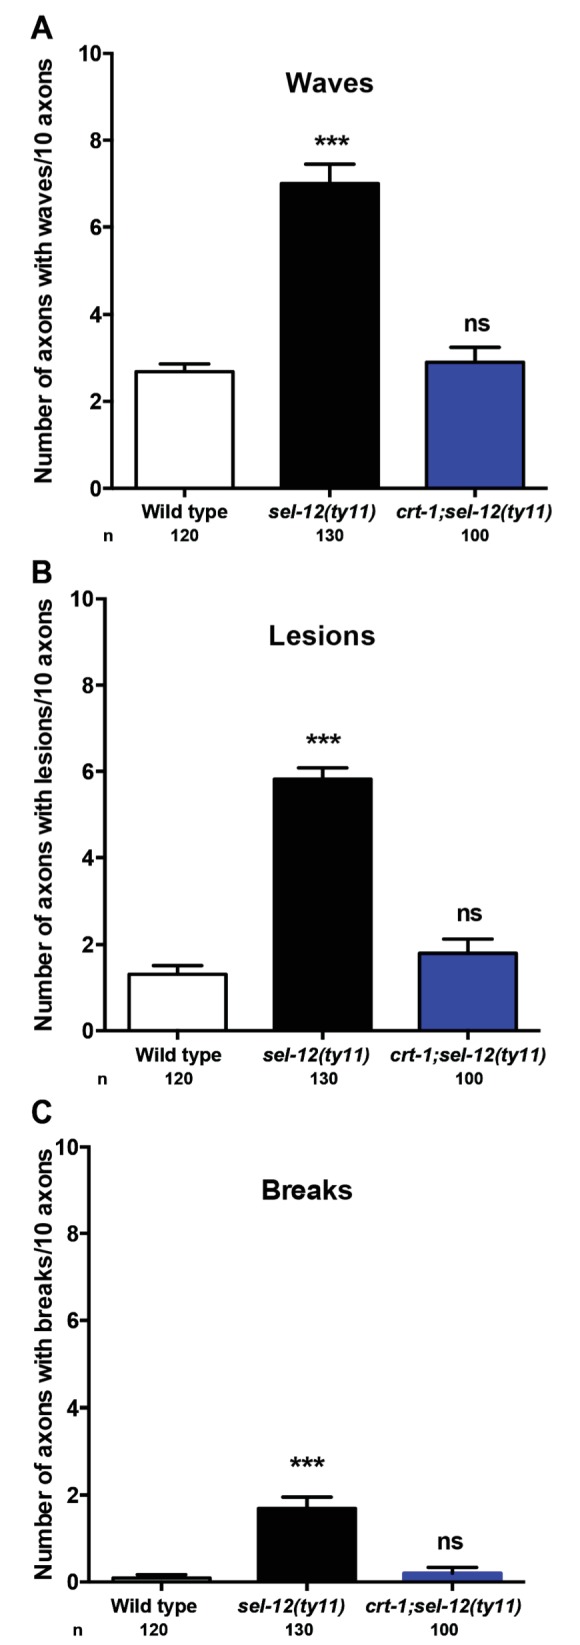
Reduction of ER Ca2+ release improves the structure of mechanosensory neurons in sel-12 animals.Quantification of the frequency of (A) wave-like processes, (B) lesions and (C) breaks in ALM and PLM neuronal processes in wild type, sel-12(ty11) and crt-1;sel-12(ty11) animals at day 1 of adulthood. Neuronal morphology analysis is done using transgenic animals expressing mec-4p::GFP (zdIs5). n = number of animals analyzed per genotype. Data are displayed as mean ± SEM, and all comparisons have been made to wild type animals unless otherwise indicated. ns p>0.05, ***p<0.0001 (One way ANOVA with Tukey test).10.7554/eLife.33052.026Figure 6—figure supplement 2—source data 2.Raw data for Figure 6—figure supplement 2.